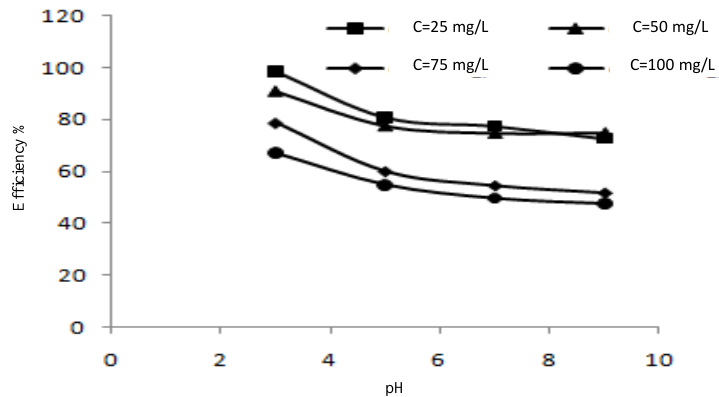
Figure 5. Effect of pH on the adsorption of AR18 onto MWCNTs in different dye concentration (adsorbent dosage =0. 04 g/100 mL, contact time= 120 min, T= 25 o C).